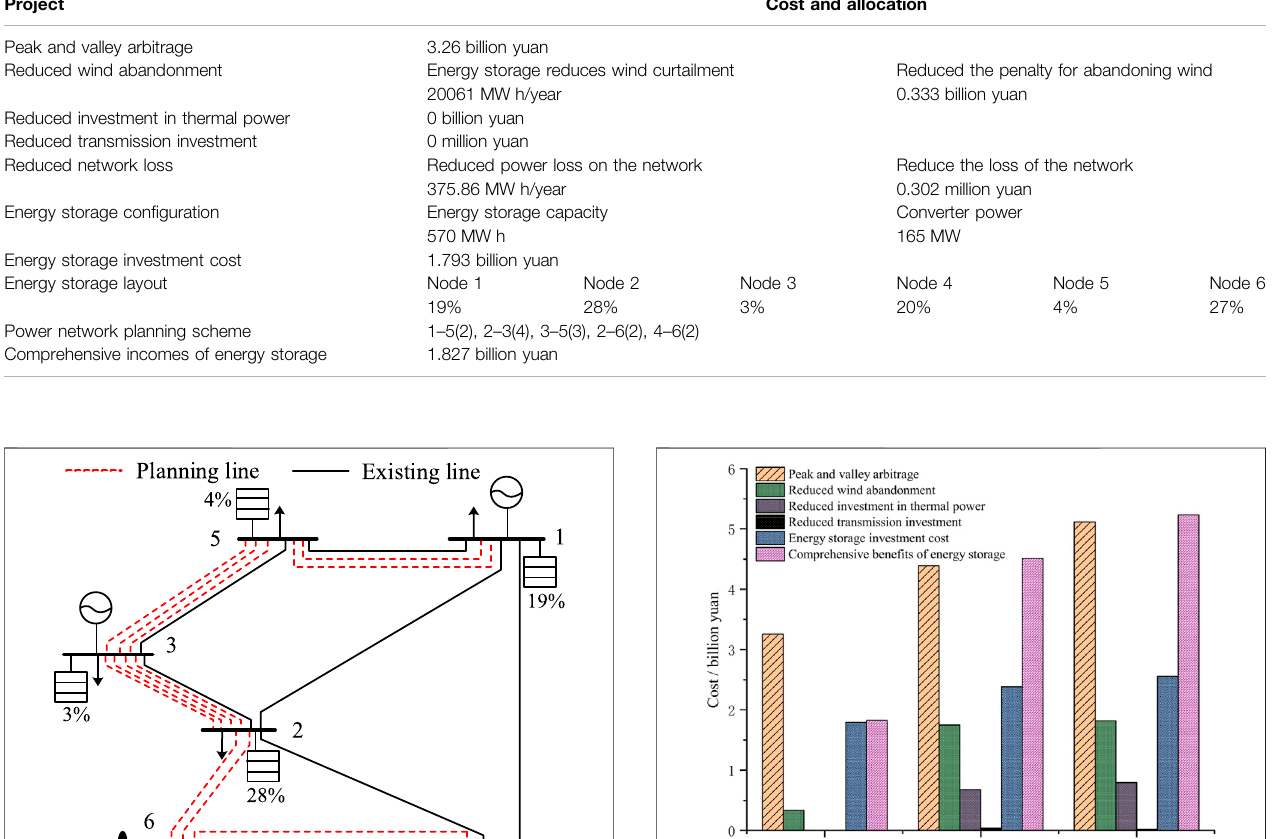
TABLE 5 | Planning scheme under fi xed time-of-use electricity price strategy. Project